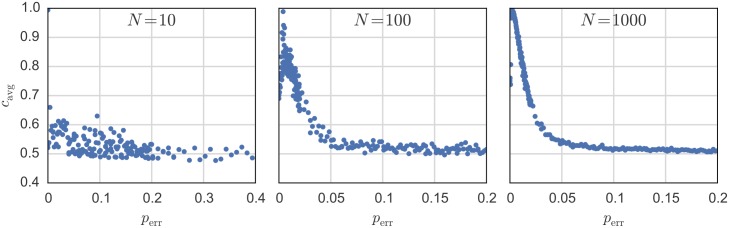
Influence of communication error probability perr on systems with different sizes N.The parameters are λmin = 0.005, RV = 2Ω, R0 = R/N = 200Ω and V = 1 V. The communication network is configured as a ring.